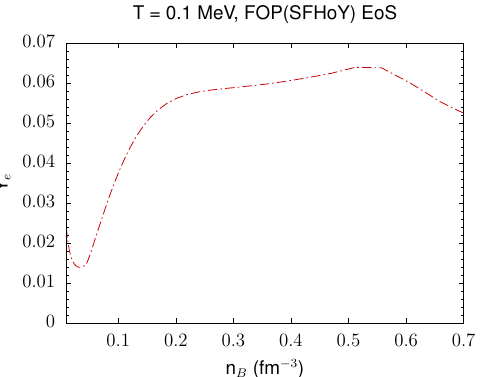
Figure 1. The electron fraction in β -equilibrium for the FOP(SFHoY) EoS at T = 0.1 MeV as function of baryon number